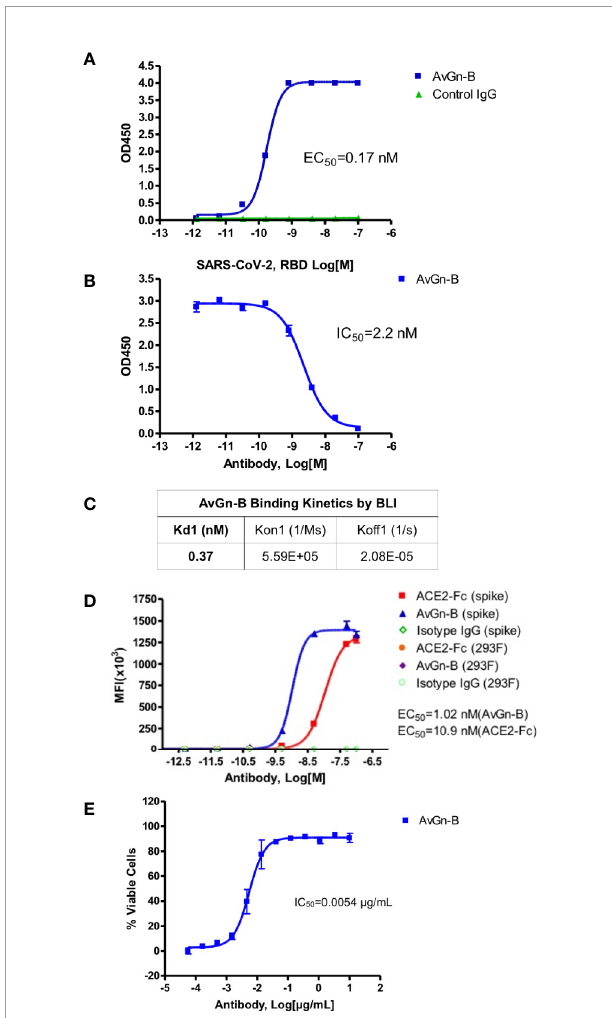
FIGURE 1 | Properties of clone AvGn-B. (A) Binding curve of biotinylated RBD to the virus neutralizing AvGn-B clone by ELISA. (B) IC 50 curve of the AvGn-B for competing binding of SARS-CoV-2 RBD to immobilized ACE2-Fc receptor. (C) Binding kinetics of RBD to AvGn-B measured by BLI, using an Octet system. (D) Binding curve of clone AvGn-B compared to ACE2-Fc or isotype control IgG to 293 cells expressing full-length SARS-CoV-2 spike protein as a GFP-fusion protein. (E) EC 50 curve for the ability of clone AvGn-B to neutralize viral-induced cell death in the CPE assay. Curve fi tting in (A , B , D , E) was performed using Prism